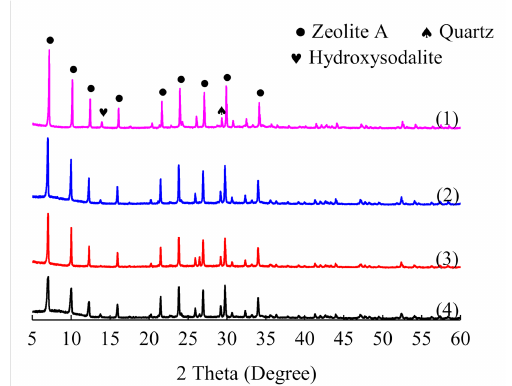
Figure 5. XRD of zeolite A synthesized by di ff erent m(NaOH) / m(CGFS) in solid-phase alkali fusion. Reaction conditions: solid-phase alkali fusion temperature, 823 K; liquid / solid ratio, 5.5 mL / g; hydrothermal reaction temperature, 353 K; and hydrothermal reaction time, 12 h. m (NaOH) / m (CGFS): (1) 1:1.6, (2) 1:1.5, (3) 1:1.2, and (4) 1:1.